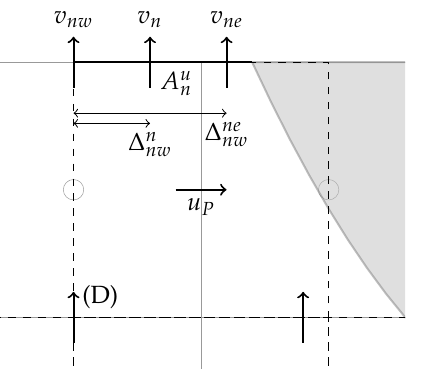
Figure 3. Case (D) cut u -cell interpolation for v n at cut face A u n , v nw , v ne on